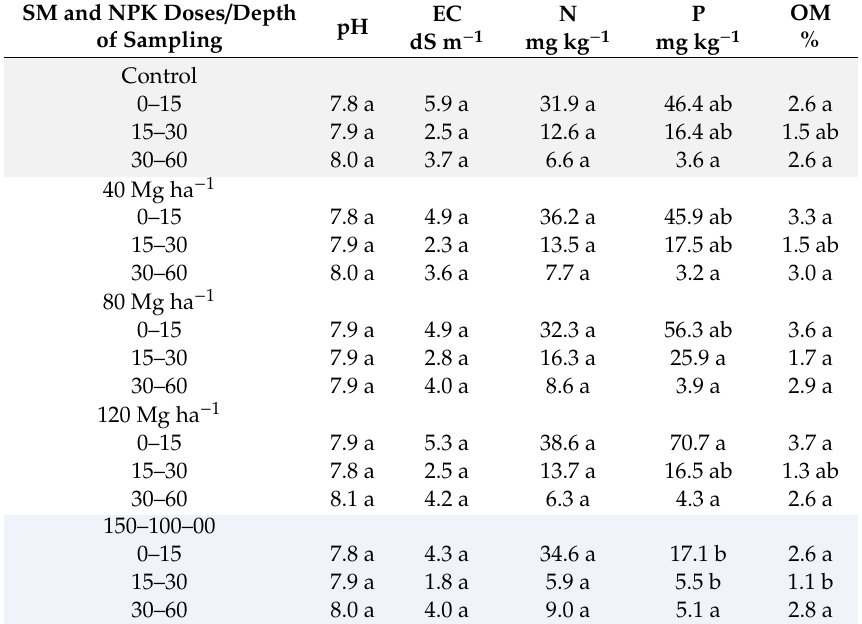
Table 4. A comparison of the means of the soil variables at the end of the 2014 summer agricultural season in a jalapeño pepper crop with SM and inorganic fertilizers; G ó mez Palacio, Durango.,